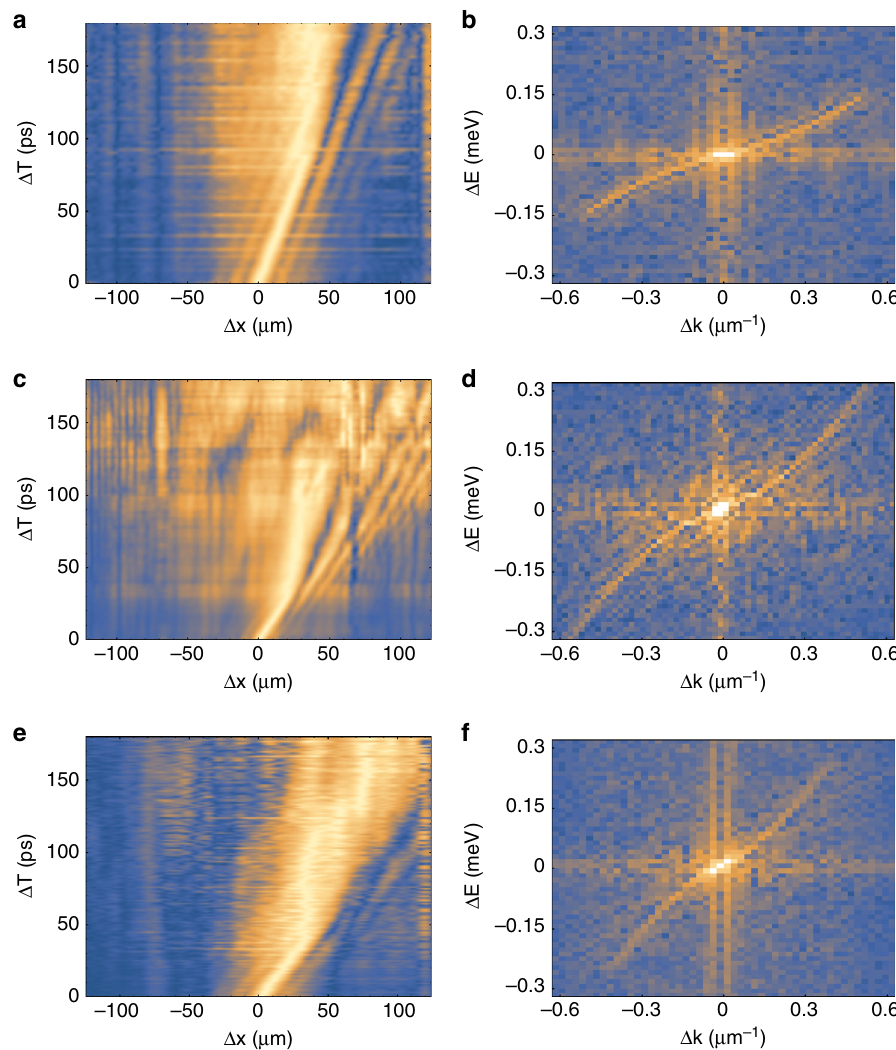
Fig. 2 Excitation spectrum by Fourier Transform of correlation measurements. First order correlation g ð 1 Þ ð Δ x ; Δ t Þ in space and time for increasing pumping powers (from top to bottom). P ¼ 0 : 9 P th , P ¼ P th and P ¼ 1 : 5 P th in ( a , c , e ), respectively. b , d , f The Fourier transforms of ( a , c , e) ,